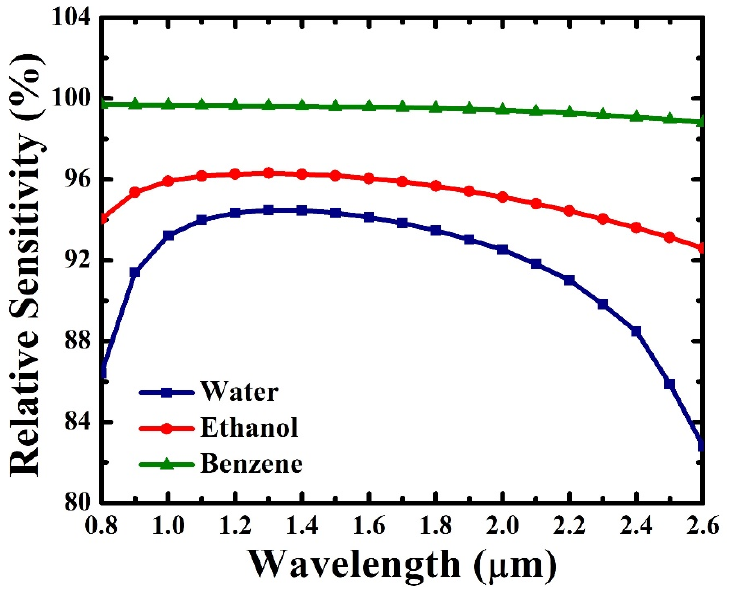
Figure 5. Proposed PCF sensor results for relative sensitivity with respect to wavelength for water, ethanol and benzene.